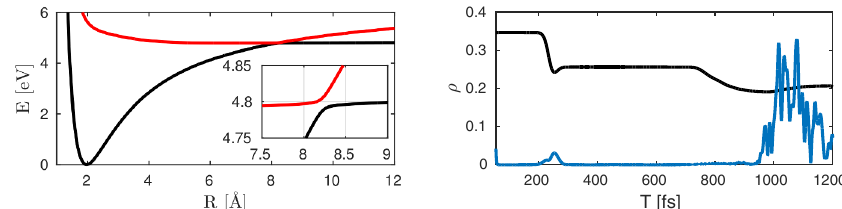
Fig 2. Right panel: Time evolution of the excited-state population ( A 1 Σ , black) and the magnitude of the coherence | ρ eg | (blue). The coherence at 220fs is created by the outward wave packet passing through the avoided crossing, while the strong coherence around 1100fs corresponds to the wave packet return to the Franck-Condon region. Left panel: Potential energy curves of NaF (black X 1 Σ , red A 1 Σ ). The wave packet branches at the avoided crossing at 8.3 ˚A. Figures reused from [3]